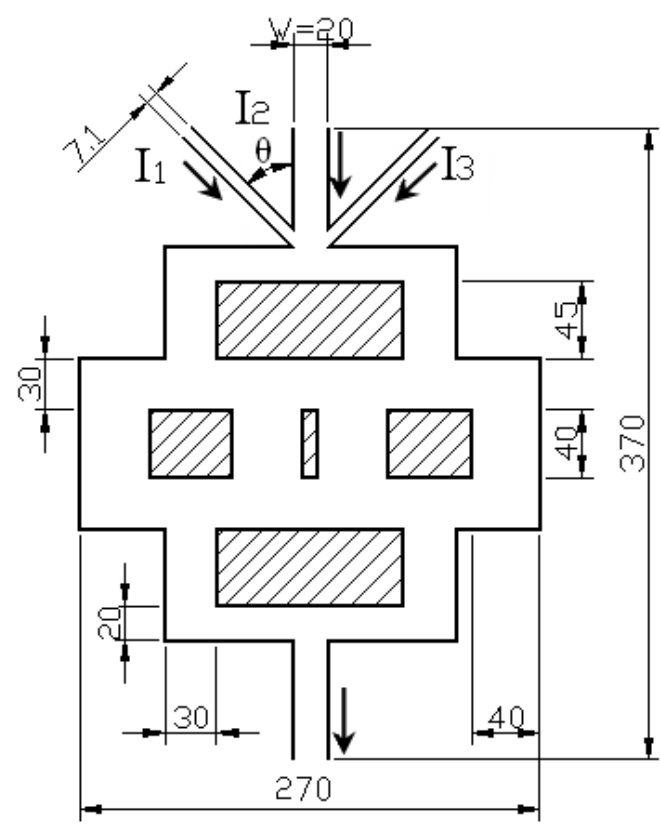
Figure 1. Prototype of biophysical micromixer (unit: μ m), the arrows indicate the inlet and outlet flow